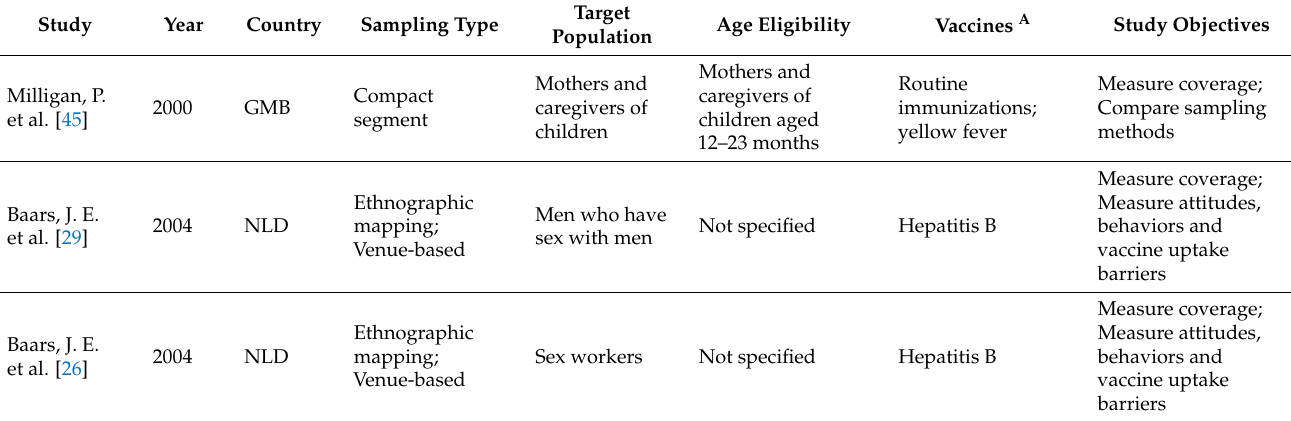
Table 1. Characteristics of included studies and major themes of adaptive sampling use.